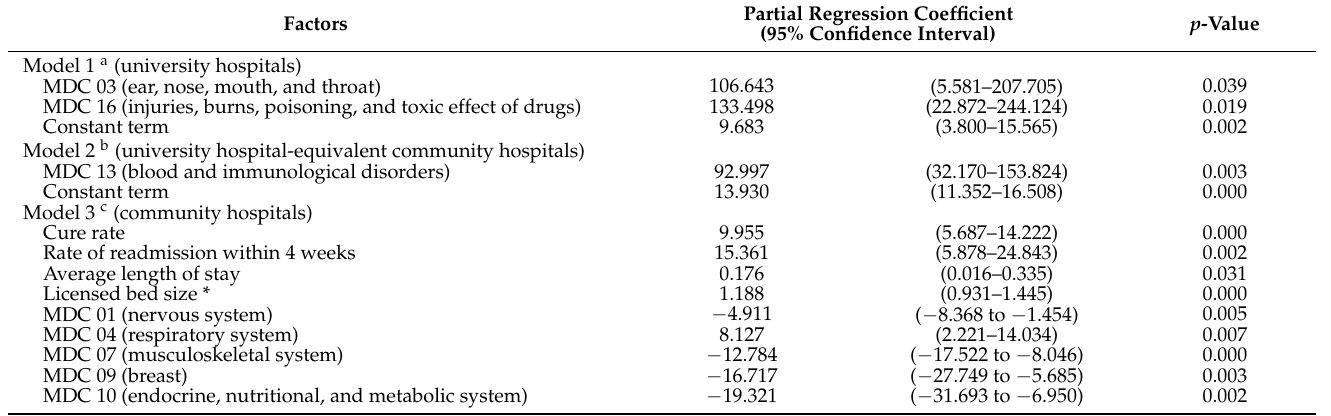
Table 3. Multivariable linear regression models of associated factors of carbapenem consumption by facility